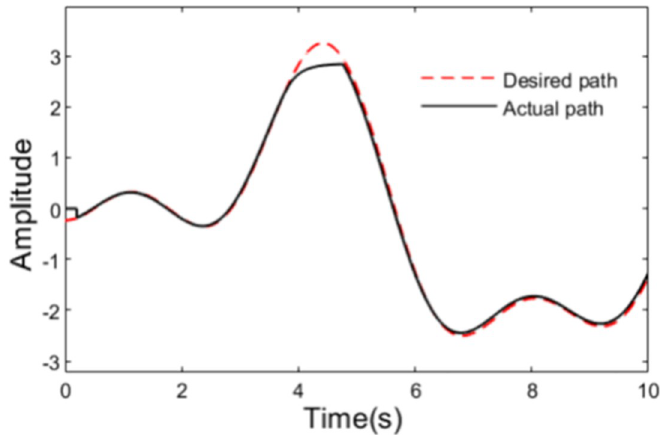
Fig 8. Desired and actual path.